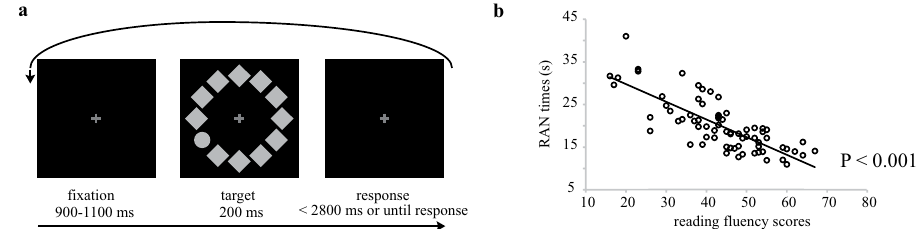
Figure 1. ( a ) Trial sequence of the visual search paradigm. ( b ) Scatter plot depicts the relationship between RAN times and reading fluency scores in Chinese-speaking